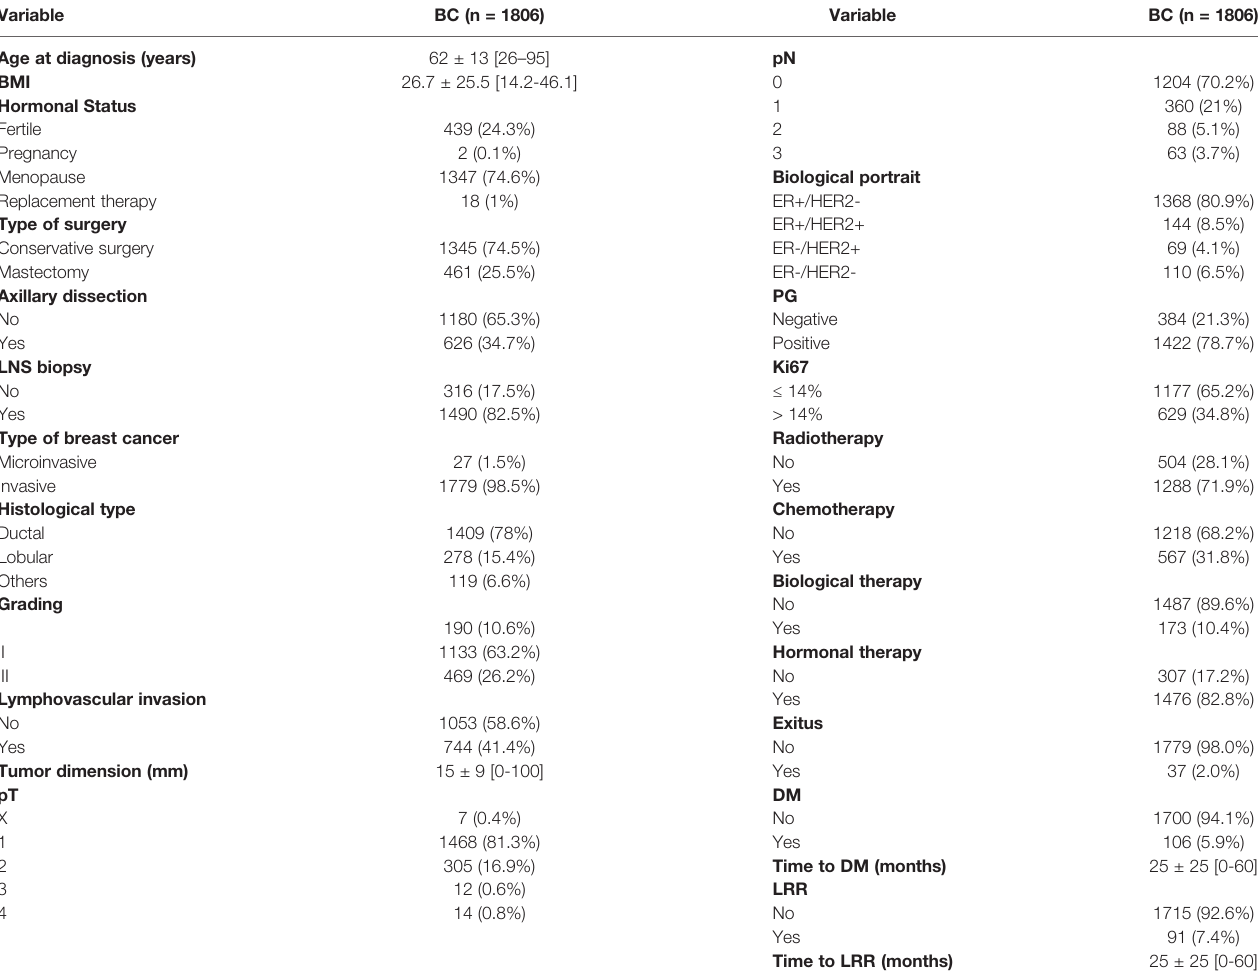
TABLE 1 | Clinical and pathological characteristics of the study population (n=1806 breast